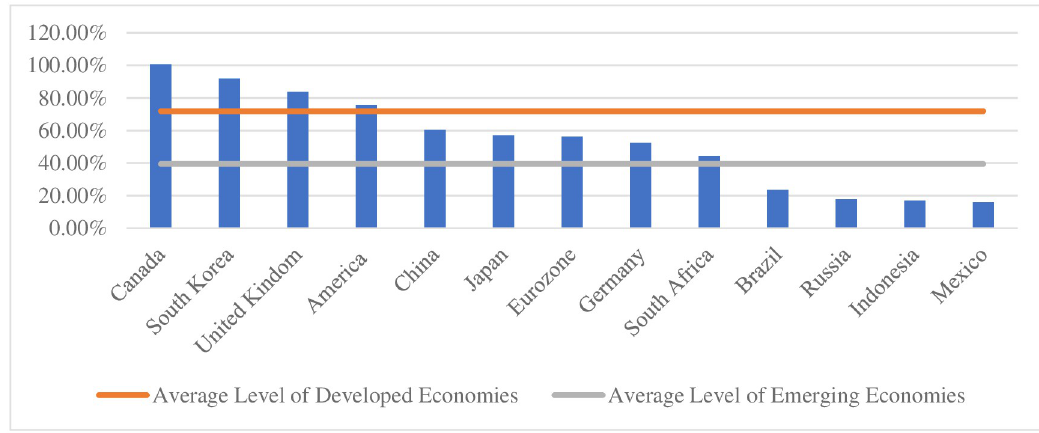
Fig 3. International comparison of residents’ leverage